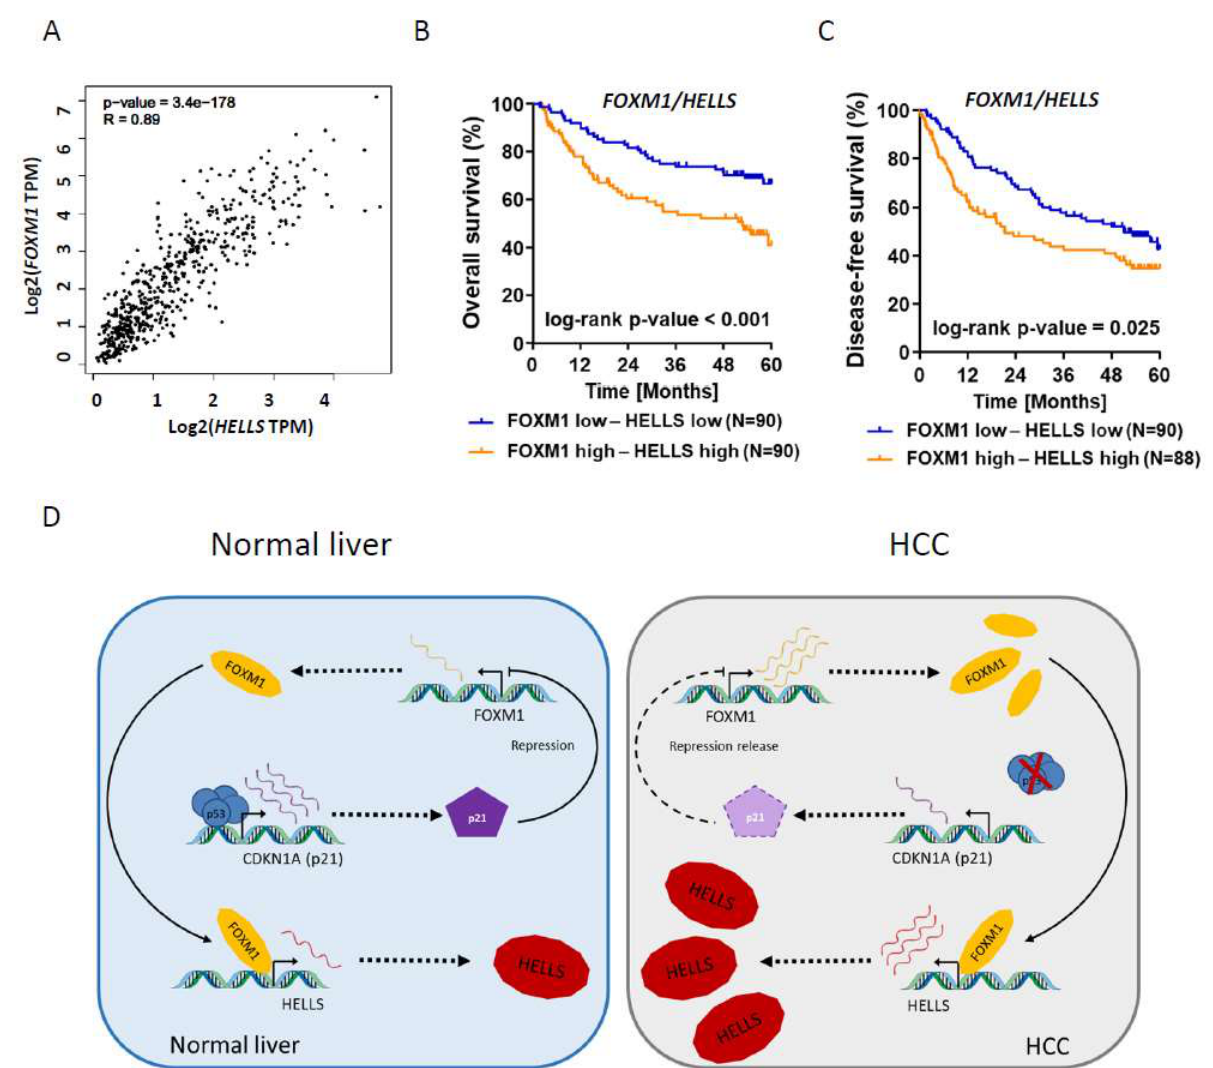
Figure 7. Statistical analysis of HELLS and FOXM1 in various aspects. ( A ) Correlation between HELLS and FOXM1 expression in human HCC based on a TCGA data set. ( B ) Overall survival of HCC patients with high-high or low-low expression of HELLS and FOXM1 based on a previously published transcriptomic data set by Roessler et al. [30]. ( C ) Disease-free survival of HCC patients with high-high or low-low expression of HELLS and FOXM1 based on a previously published transcriptomic data set by Roessler et al. [30] ( D ) Illustration of the regulatory link between P53 and HELLS: Normal liver tissue (left panel): P53 induction leads to reduced HELLS expression via P21-dependent repression of FOXM1 . In HCC (right panel): Non-functional P53 (either mutated or functionally inactivated) results in a repression relieve leading to FOXM1 overexpression and consecutively HELLS overexpression.